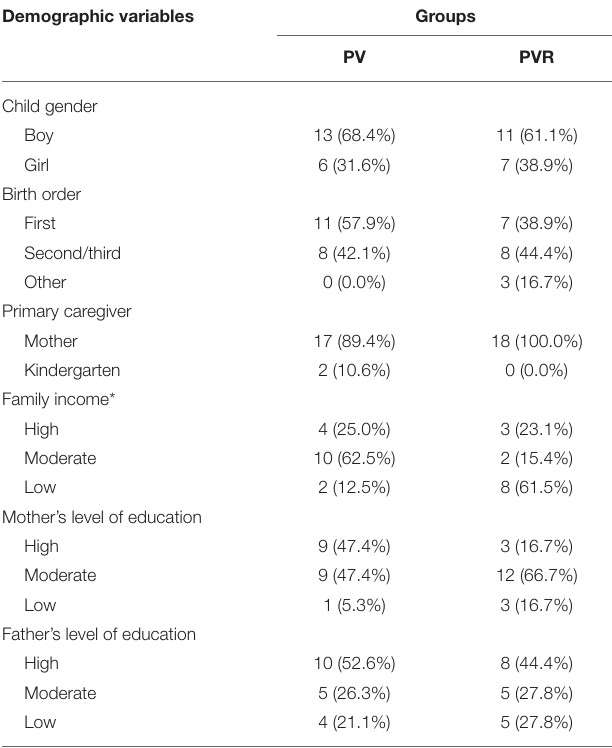
TABLE 1 | Demographics of study participants ( n = 37). Demographic